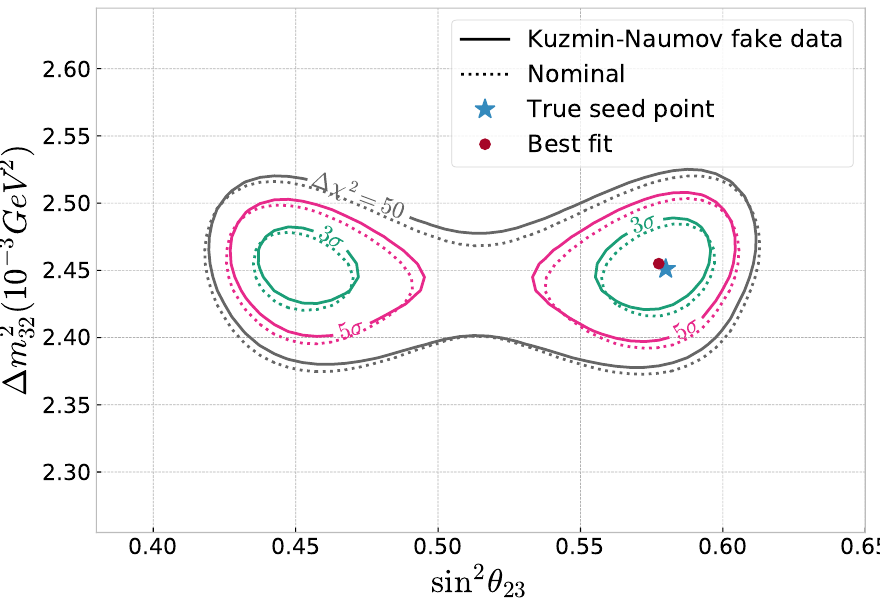
Figure 146. Comparisons of oscillation sensitivity contours for ν µ disappearance when fitting a mock dataset thrown with the nominal GENIE cross section model (dotted contours) or the alternate n ch Kuzmin–Naumov fit for the distribution in the hadronization model. Green are 3 σ contours, (cid:104) (cid:105) pink are 5 σ contours, and the gray contours correspond to much higher confidence at ∆ χ 2 = 50 (to illustrate the effect near maximal disappearance). The best fit point (red dot) moves less than 1% in both sin 2 θ 23 and ∆ m 2 from the true value (blue 32